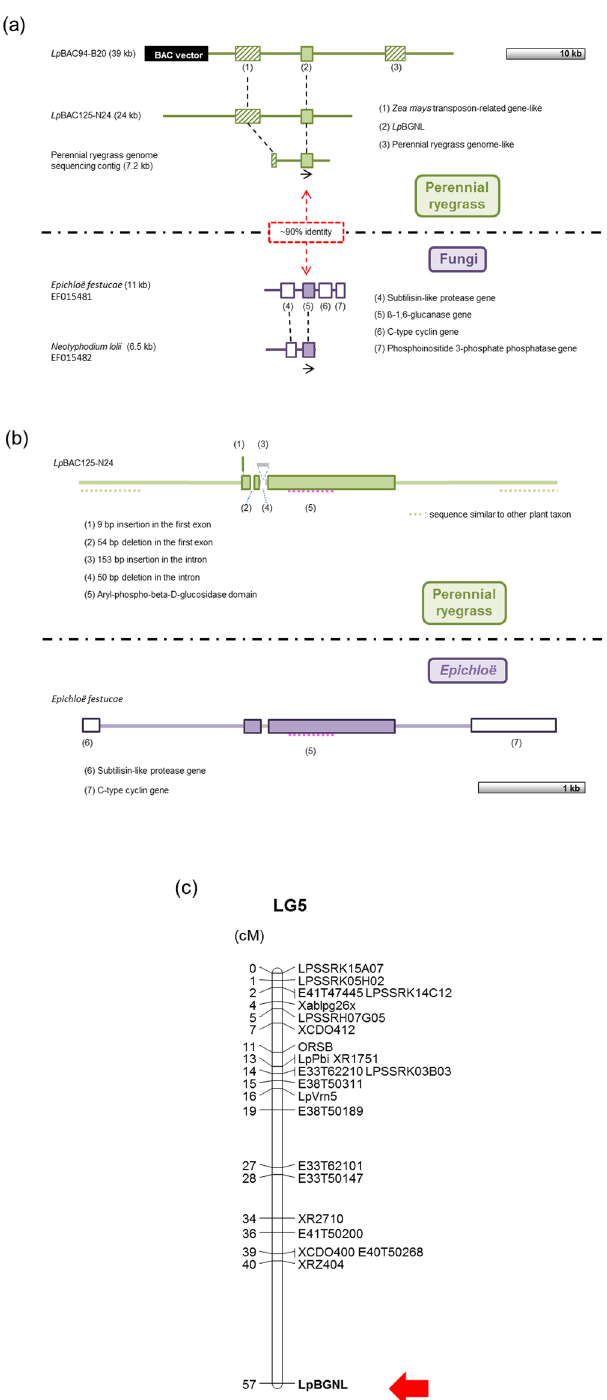
Figure 2. Genome structure of the Lp BGNL and E . festucae ß-1,6-glucanase genes and genetic linkage analysis for Lp BGNL. ( a ) Alignment of genome sequences from perennial ryegrass and Epichloë species. The light green- filled and striped boxes show the location of Lp BGNL and the plant genome-related sequence, respectively. The black-filled box represents the BAC vector. The purple-filled and empty boxes show the location of the ß-1,6- glucanase gene and flanking gene, respectively. The transcription direction of the genes is indicated with the arrow. Corresponding gene sequences are connected with black dashed lines. ( b ) Alignment of coding regions of the Lp BGNL and Epichloë ß-1,6-glucanase genes. The light green and purple lines represent non-gene coding region of perennial ryegrass and Epichloë species. The grey line and pink breaking line show the location of the intron and aryl-phospho-beta-D-glucosidase domain, respectively. ( c ) Genetic linkage map of perennial ryegrass LG5 with the Lp BGNL-related locus. The Lp BGNL-related marker locus is indicated with the red arrow. Genetic distance (cM) is shown on the right side of the genetic